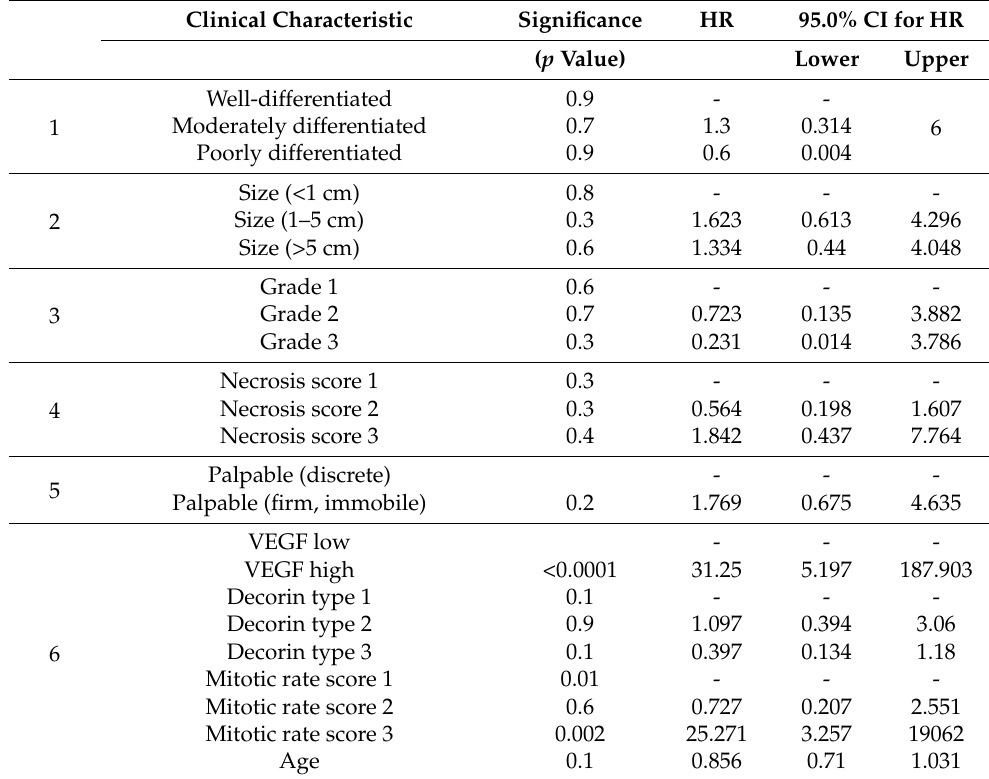
Table 4. The stepwise backward selection of variables in the IHC database using Cox regression analysis identified four characteristics of appropriate significance to be used in the nomogram. Clinical Characteristic